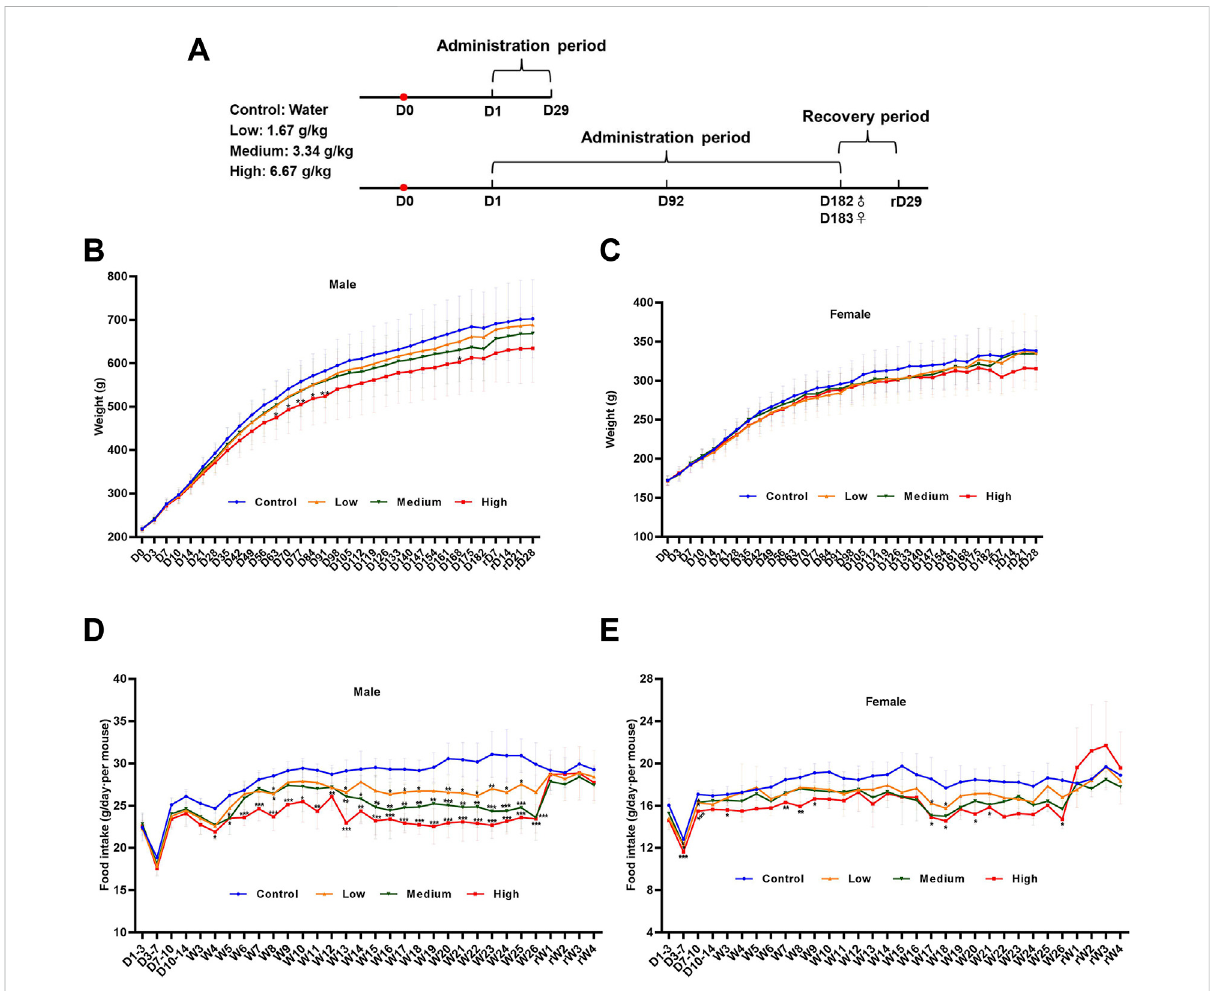
FIGURE 2 Body weight and food consumption of rats in chronic toxicity studies. (A) Timeline of the 6-month chronic toxicity study. Weights of male rats (B) and female rats (C) in the 6-month chronic toxicity study. Food consumption of male rats (D) and female rats (E) in the 6-month chronic toxicity study. Statistical analysis was performed using the one-way ANOVA. * p < 0.05, ** p < 0.01, *** p < 0.001 versus the